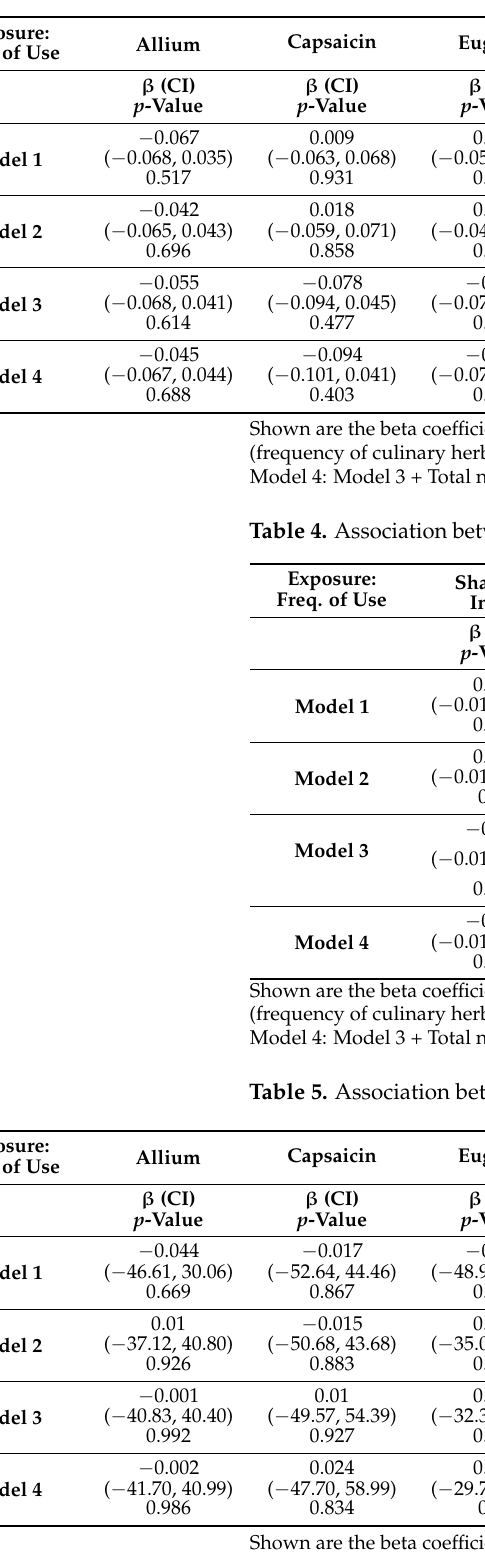
Table 3. Association between frequency of culinary herb use and Shannon Index.